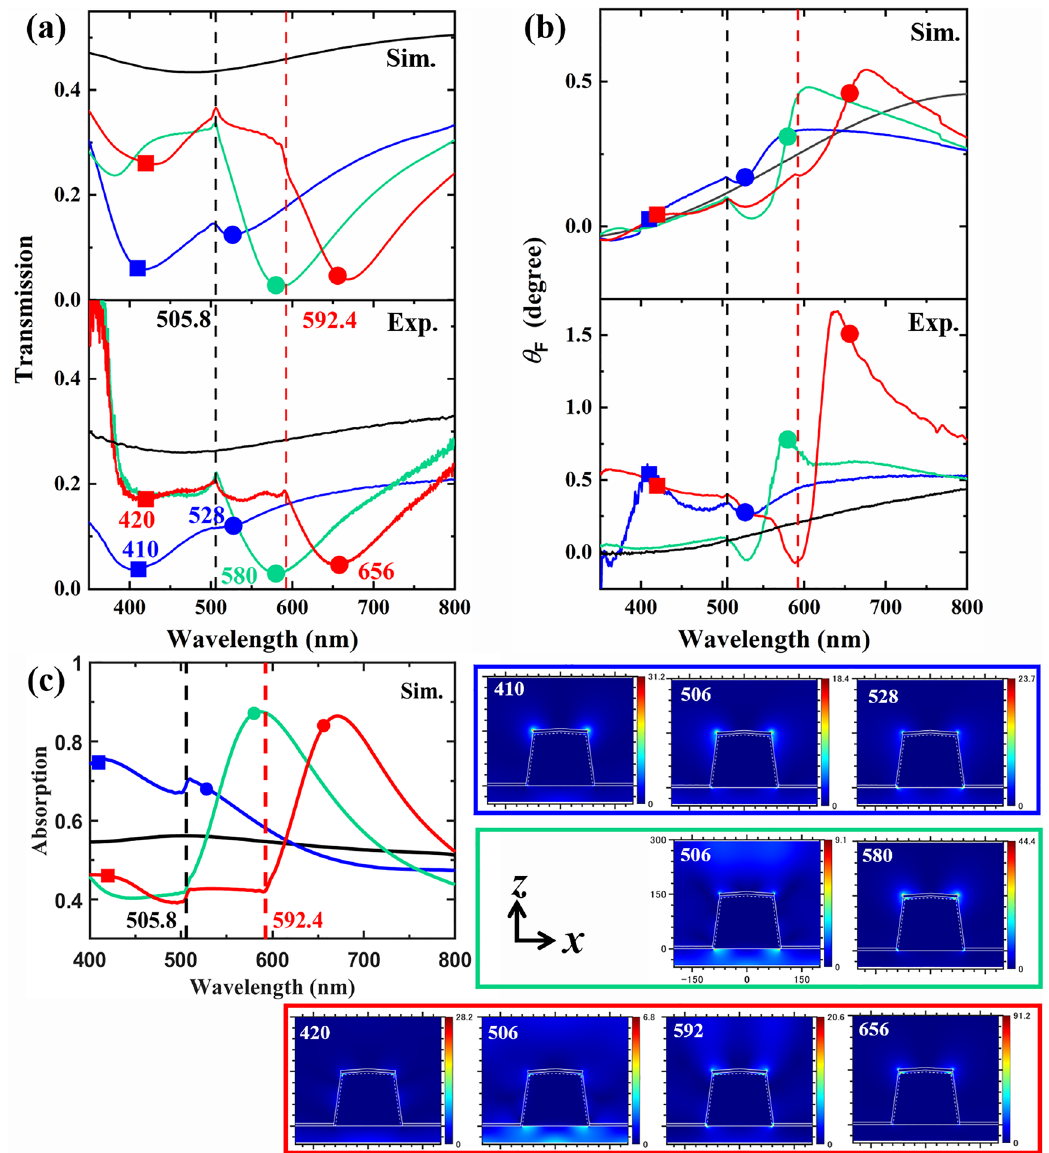
Figure 3: Calculated (upper panel, Sim.) and experimental (lower panel, Exp.) spectra of (a) optical transmissionand (b) Faraday rotation